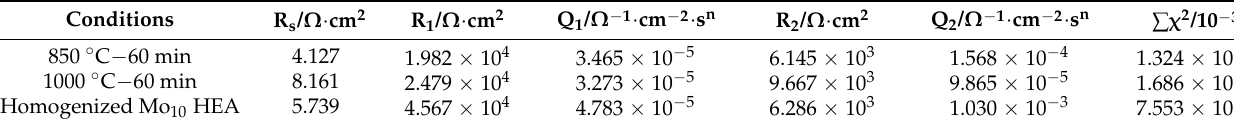
Table 4. The equivalent circuit fitting parameters.